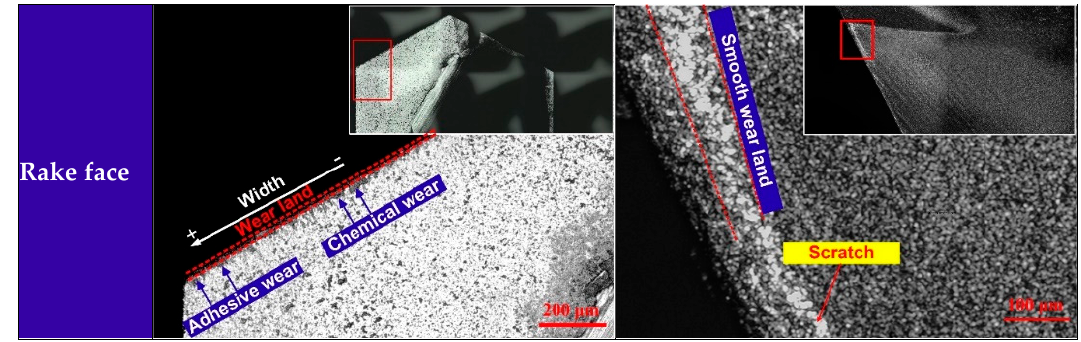
Figure 3. Wear morphologies of PCD and CVD diamond coated tools after drilling Al6063/SiC p /65p composites using 3D Laser Scanning Microscope VK-X200 (Keyence, Osaka, Japan).